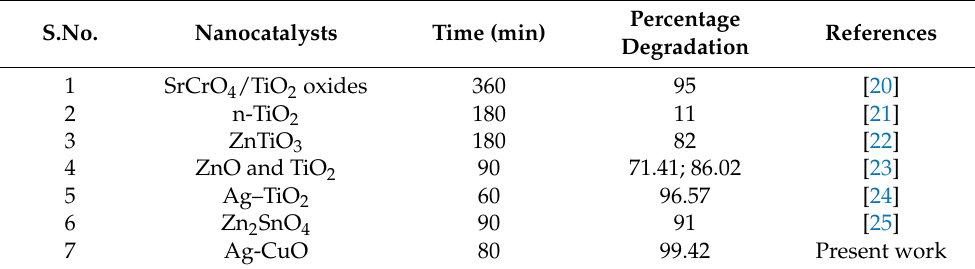
Table 1. Comparison of the photocatalytic efficacy of different nanocatalysts against rhodamine 6G.